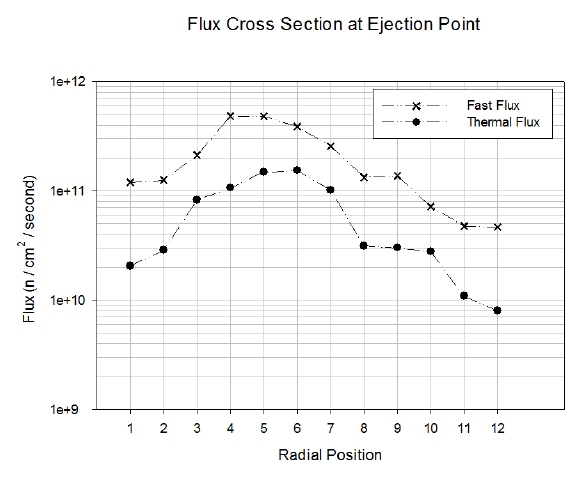
Figure 14. Flux profile cross section at ejection point.